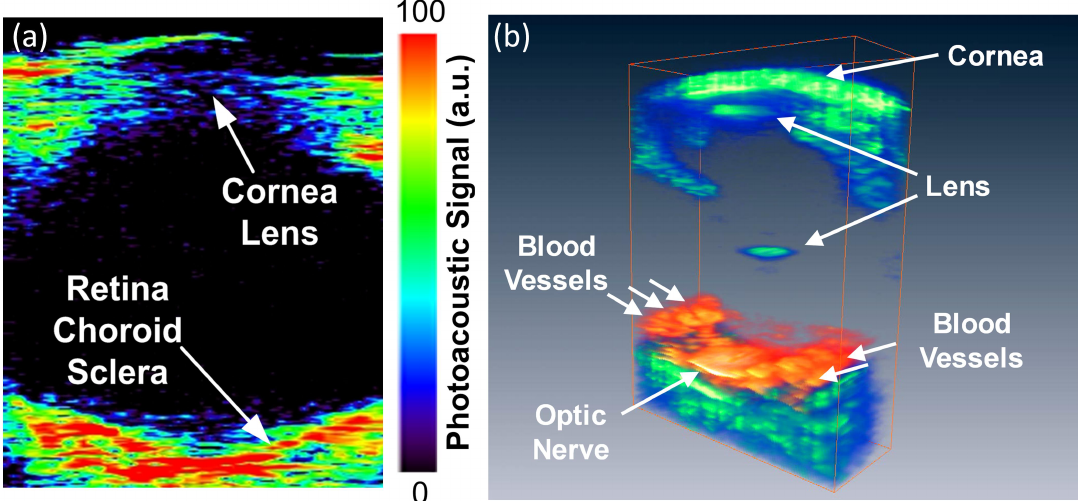
Figure 5. ( a ) Maximum intensity projection (MIP) PAM image (FOV = 12 × 8 mm) of the rabbit eye. The PAM image shows different types of retinal tissues such as, retinal choroid sclera, cornea lens, blood vessels, and optics nerve, and ( b ) three-dimensional (3D) visualization of the photoacoustic signal from the posterior eye. Laser excitation wavelength of 740 nm. Adapted with permission from ref. [22]